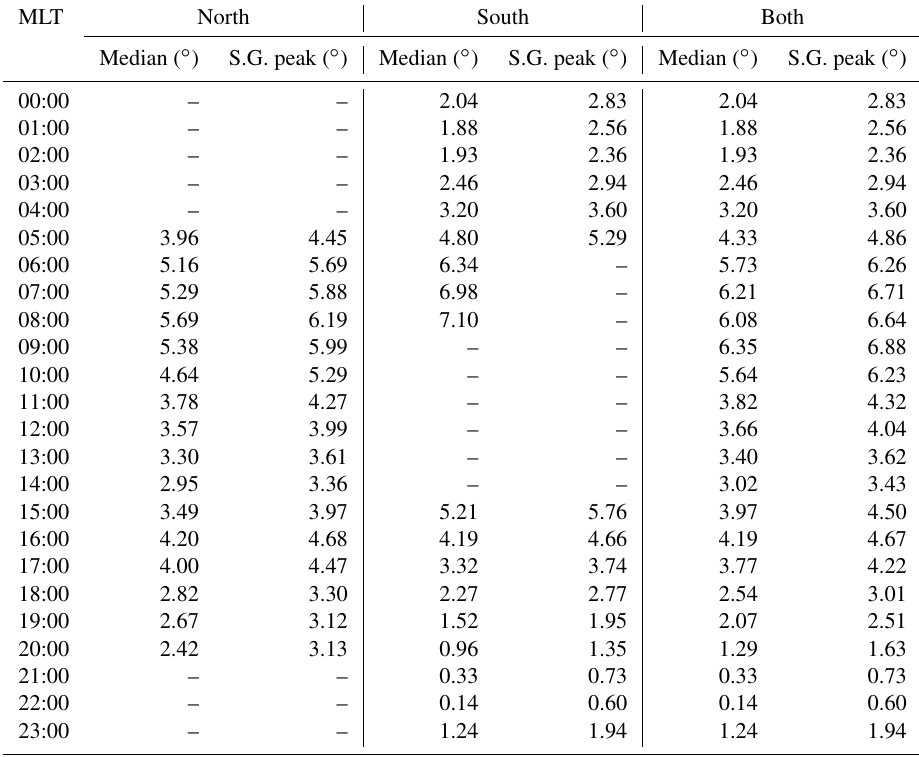
Table 1. Hourly boundary offset for hours with over 100 boundary pairs and successfully fit Gaussians.